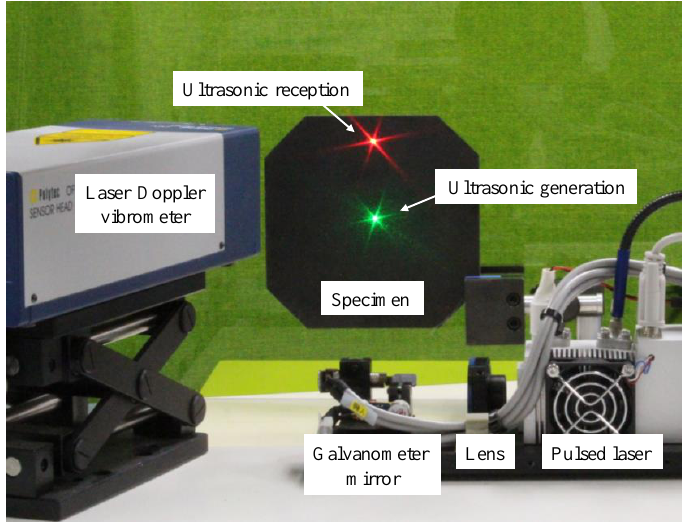
Figure 2. Photograph of the non-contact laser imaging system for visualizing ultrasonic wave propagation.